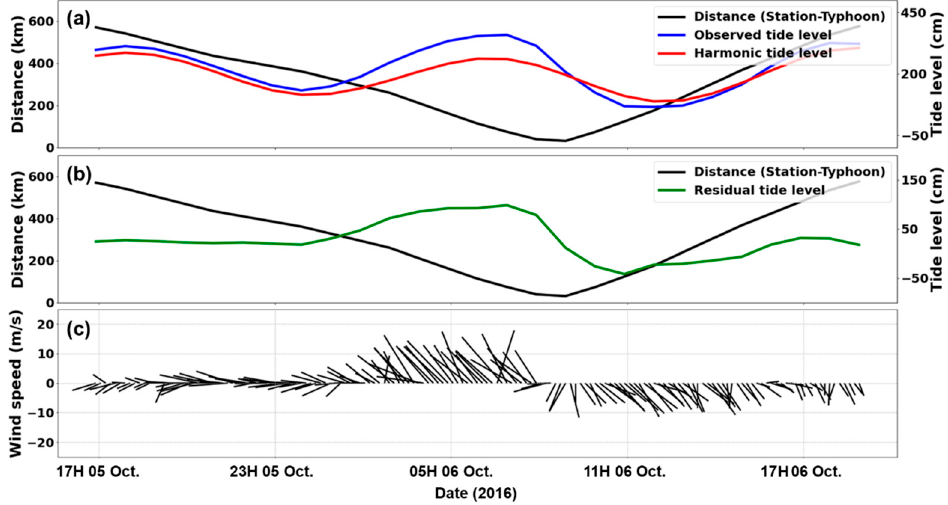
Figure 15. Time-series of observational data from Yeosu tidal station during Typhoon Kong-Rey. ( a ) Astronomical tide, ( b ) residual tide level, and ( c ) wind components, where direction and length represent wind direction and speed, respectively.